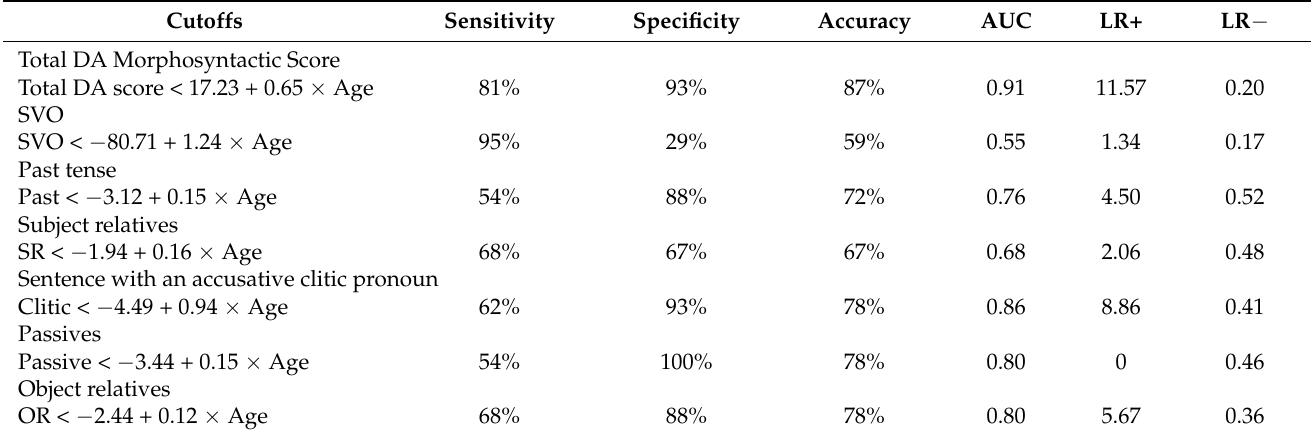
Table 7. Classification accuracy of DLD participants versus TD children by cutoff